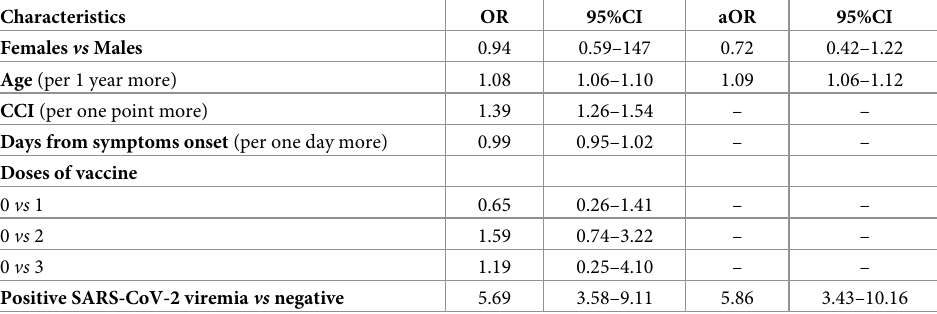
Table 3. Logistic regression analysis of factors associated with death restricted to the 3rd and 4th epidemic period.